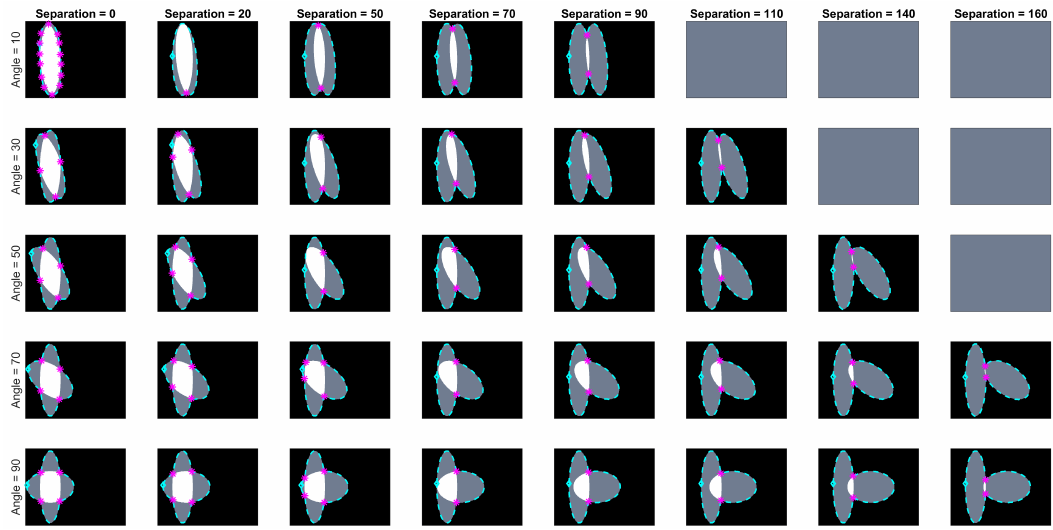
Figure 9. Junction (bends) detected for varying angles and separation distances. Five rows show angles ranging from 10 to 90 degrees and eight columns showing different separation distances from 0 to 160 pixels. Images in grey are cases where there is no overlap. The boundary of the clumps is shown in cyan (- -), with the first point in the boundary marked ( ). The junctions detected by the method are (cid:5) marked in magenta ( ∗